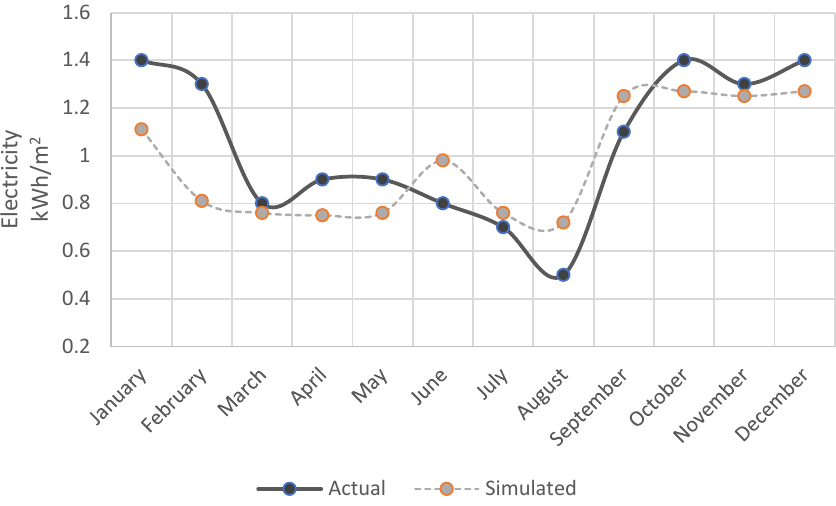
Buildings 2023 , 13 , 353 11 of 15